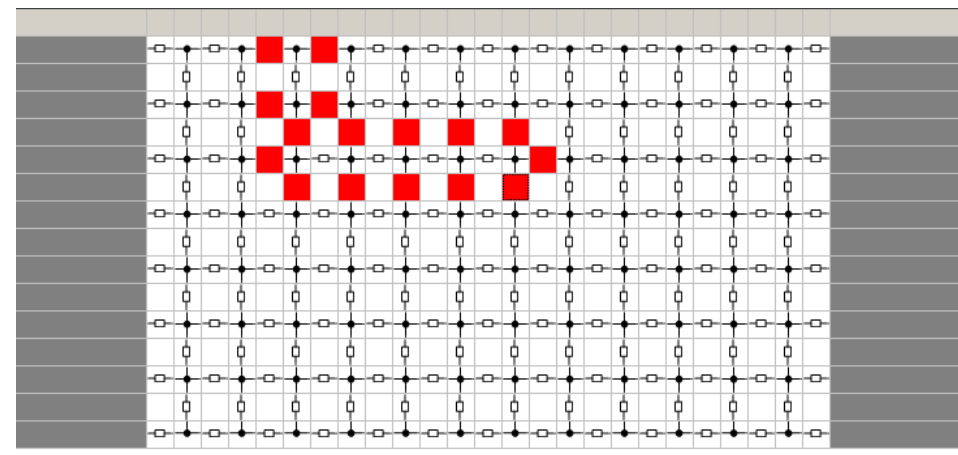
Figure 3. Detailed view of the resistor simulation model. The dimensions of the arrays are listed in Table 4. The table also contains the main characteristics of the internal model